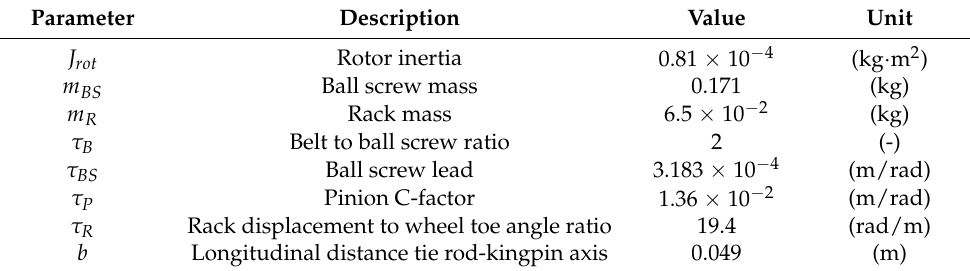
Table 2. Dynamic model